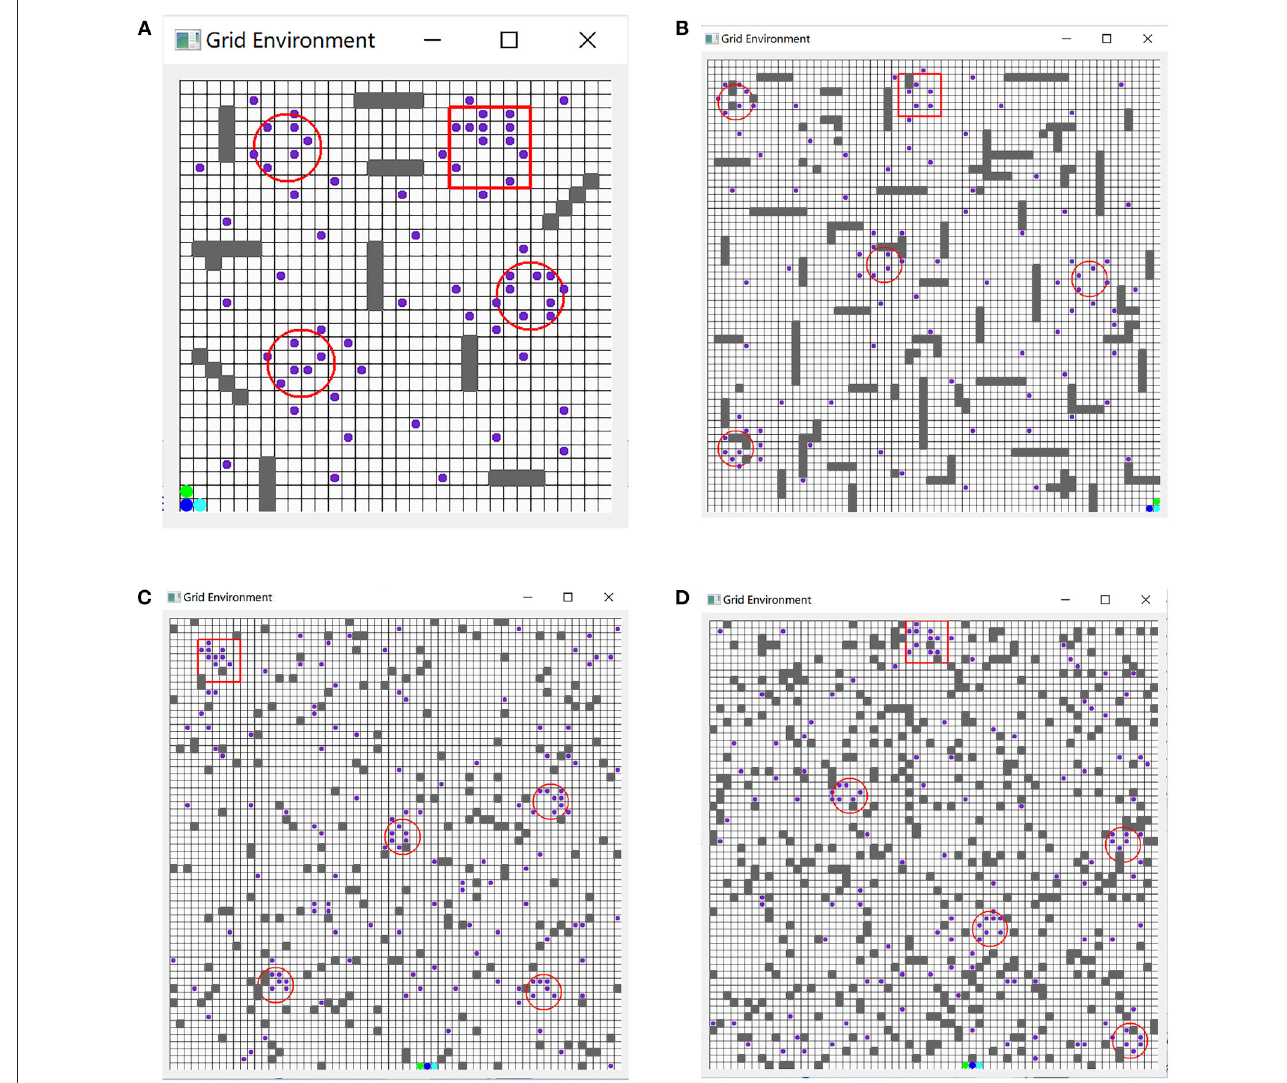
FIGURE8 Scene maps of different specifications. (A) 32*32 map of fixed scene. (B) 64*64 map of fixed scene. (C) 64*64 map with a random scene with obstacle density = 0.1. (D) 64*64 map with a random scene with obstacle density =